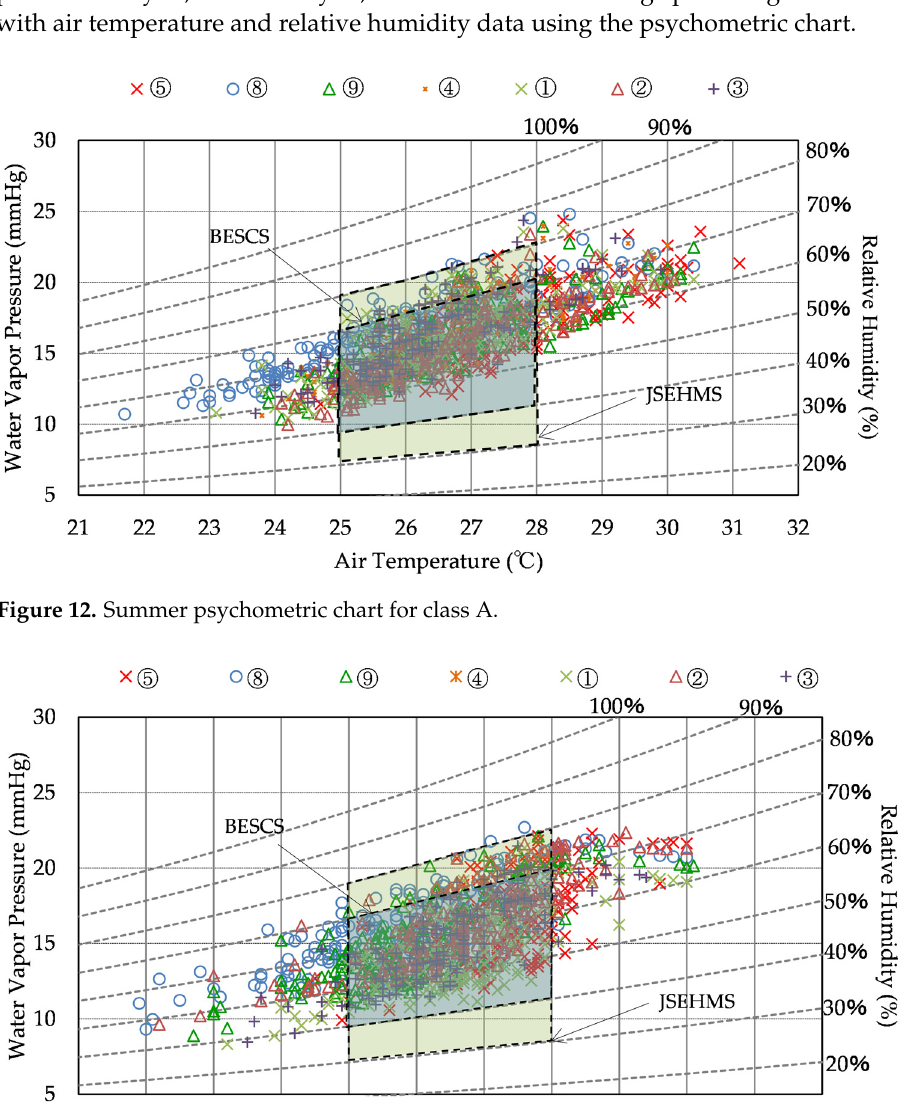
Figure 14. Summer psychometric chart for class C.